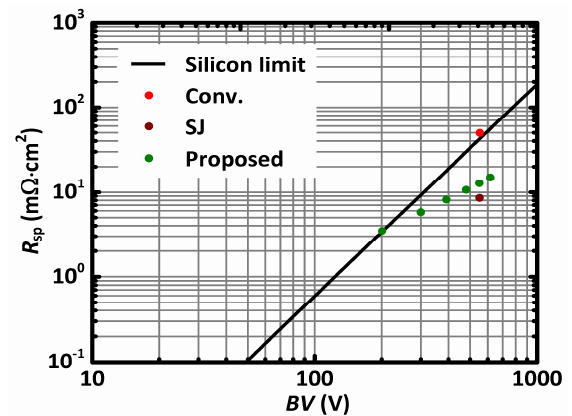
Figure 5. Relationship between R SP and BV of the MOSFETs and the 1D “silicon limit.”